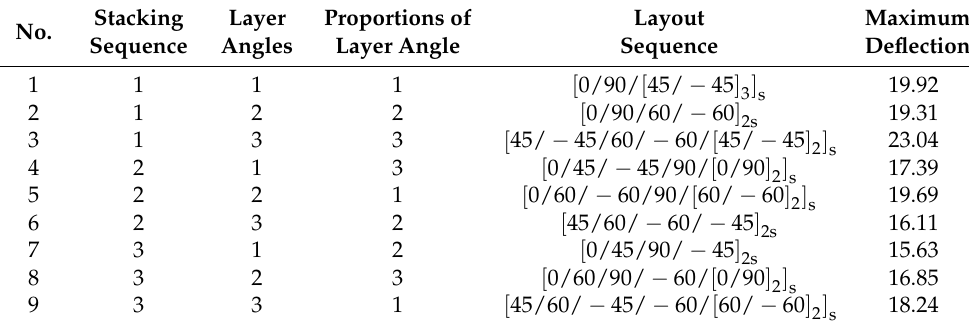
Table 5. Orthogonal experimental design and test